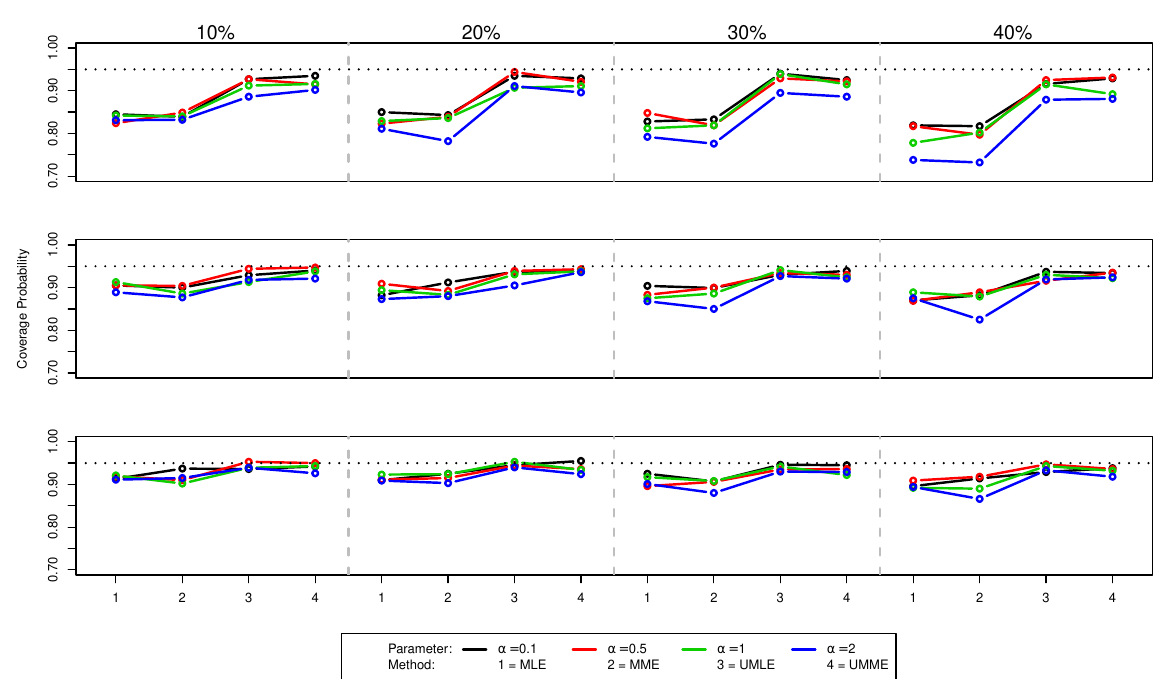
Figure 3. Coverage probabilities of α values for n = 10 ( top panel), n = 20 ( middle panel), and n = 30 ( bottom panel) for various censoring percentages.Dotted black line indicates the nominal 95% confidence